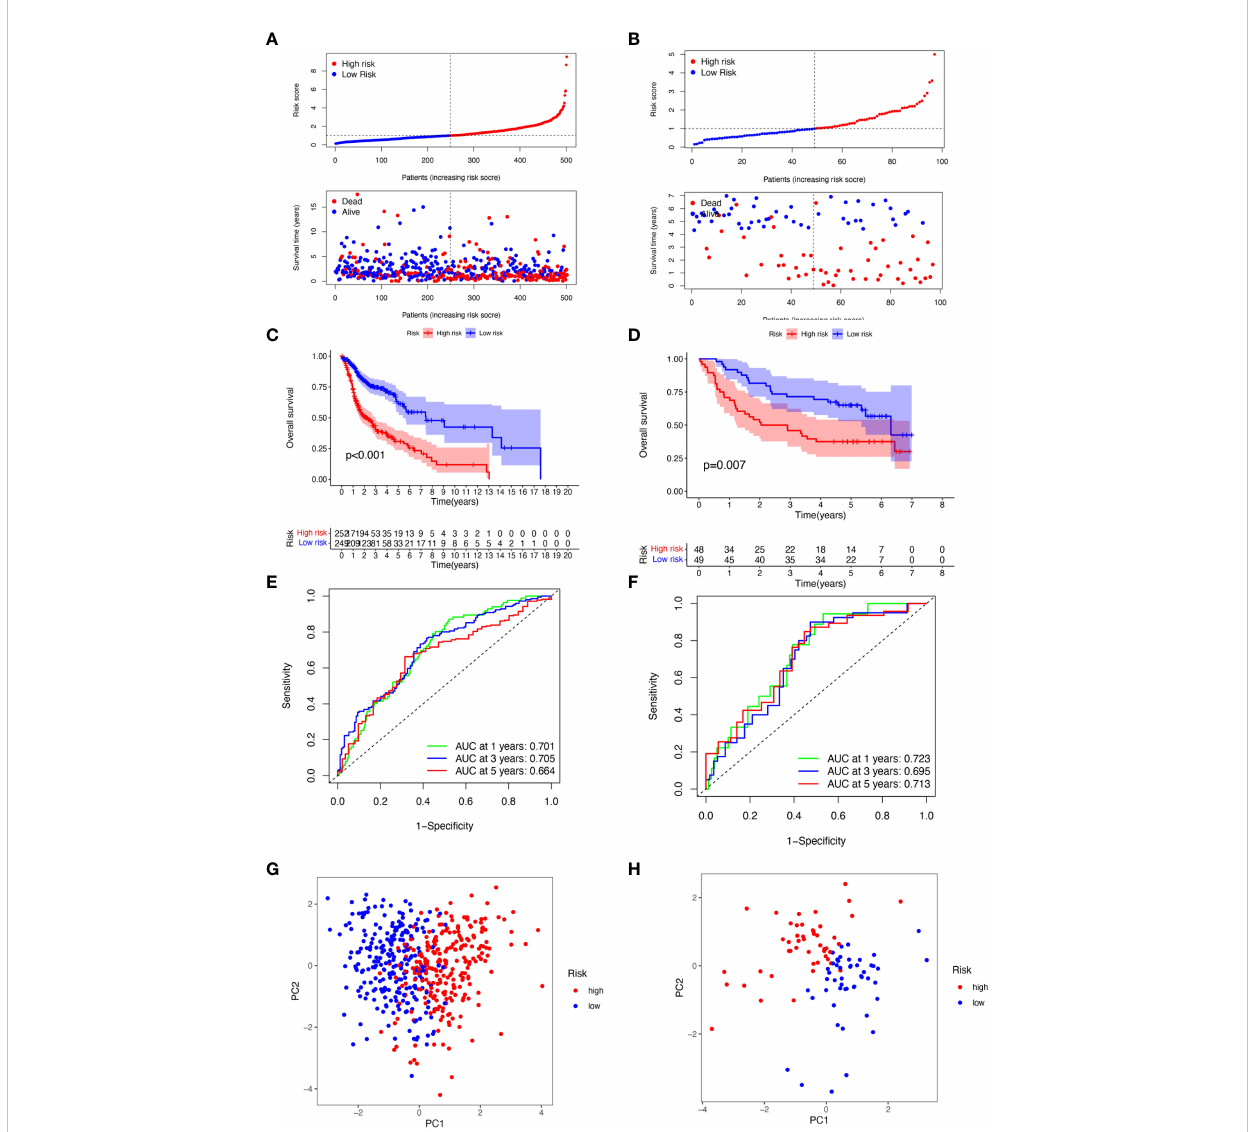
FIGURE 4 Validation of 6-CRRGs Signature. (A, B) Distribution of risk scores and patient survival between low and high-risk groups in the TCGA cohort and the GEO cohort. (C, D) KM curve compares the overall HNSCC patients between low- and high-risk groups in the TCGA cohort and the GEO cohort. (E, F) Time-dependent ROC curves analysis in the TCGA cohort and the GEO cohort. (G, H) PCA plot in the TCGA cohort and the GEO